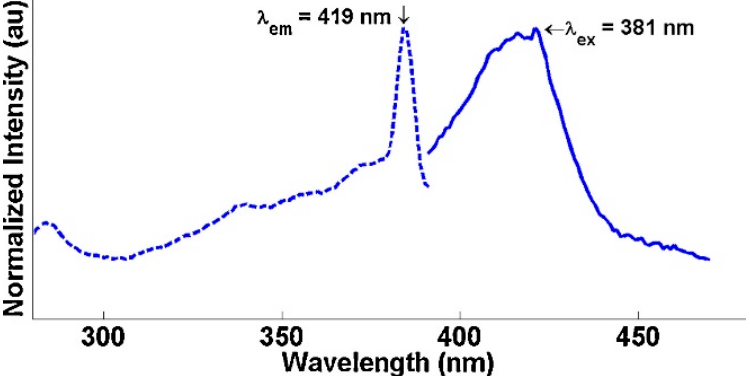
Figure 6. Solid-state luminescence spectra for BiOI at 77 K. The excitation peak is matched with its corresponding emission peak as indicated by the arrows. Reused with permission from reference [12].